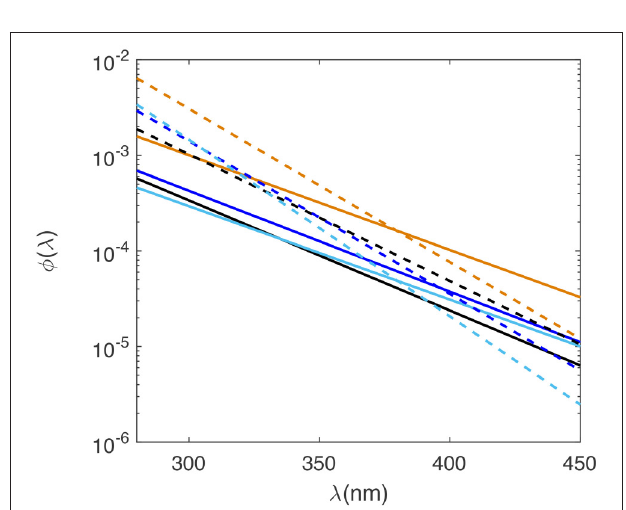
FIGURE 3 | AQY spectra for hydrogen peroxide (solid lines) and superoxide (dashed lines) for Gulf Stream (light blue), Midshelf (dark blue), Skidaway River Estuary (black), and Altamaha River (orange) samples. Note AQY spectra are plotted on a log scale.